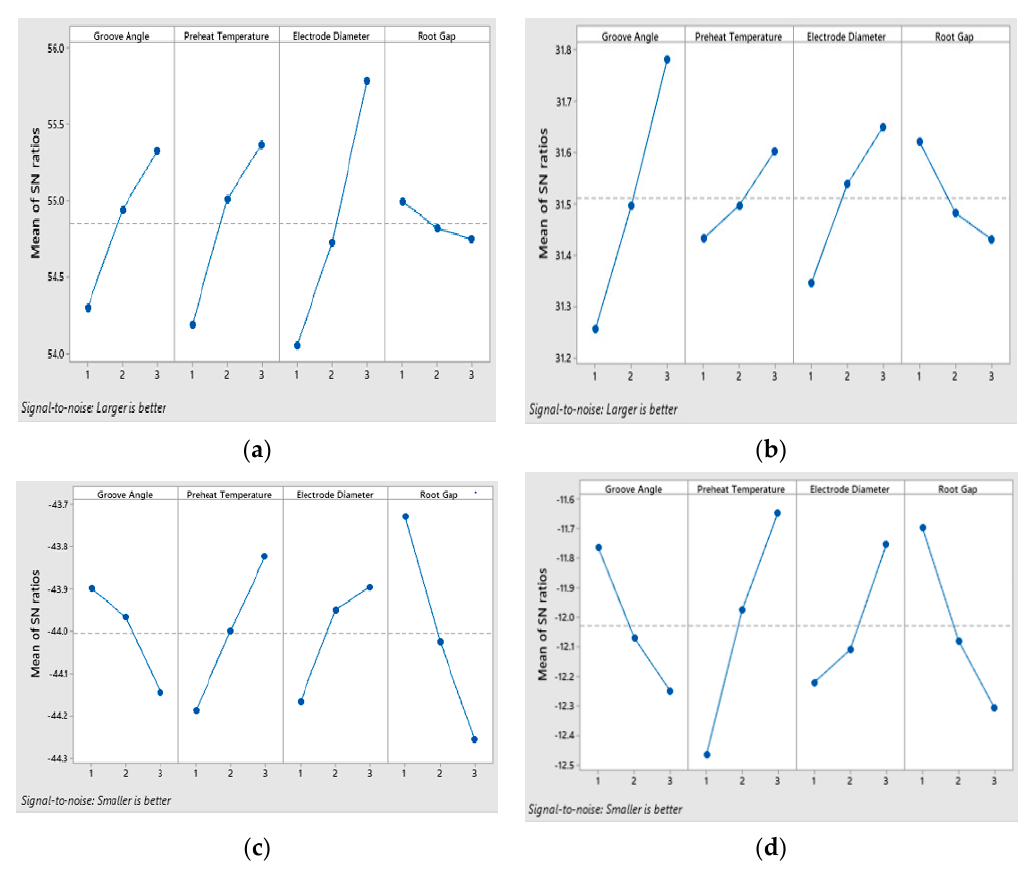
Figure 8. Main effect plot of SN ratios for ( a ) tensile strength; ( b ) impact energy; ( c ) hardness; ( d ) angular distortion.